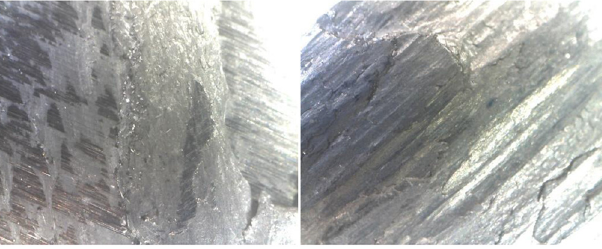
Fig. 12. Al6061 wear track.